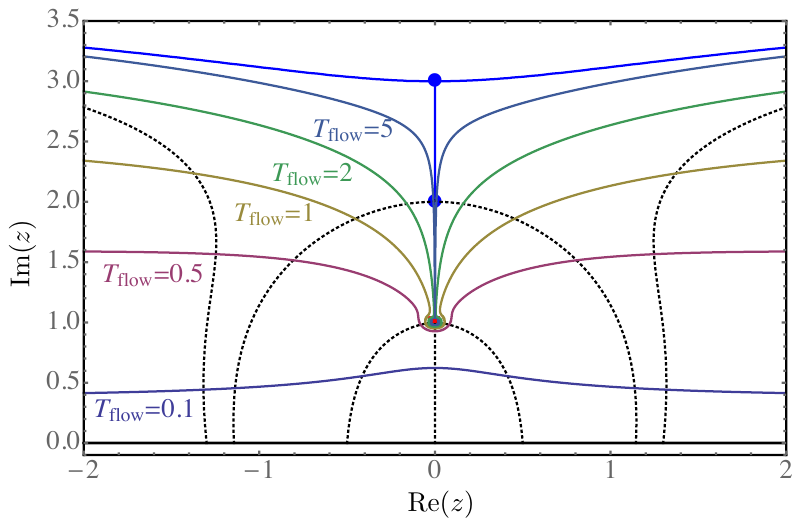
Figure 6 . Complex contours J (cid:3) ( T (cid:13)ow ) for the Gaussian model with the fermion determinant with p = 2, (cid:11) = 3, and (cid:12) = 4 (case 2). The saddle points are again denoted by the blue dots with the saddle point at 3i intersected by the Lefschetz thimble. The zero of the fermion determinant at i is represented by the red square. The black dashed curves show (cid:13)ow lines with initial condition at the intersection with the real